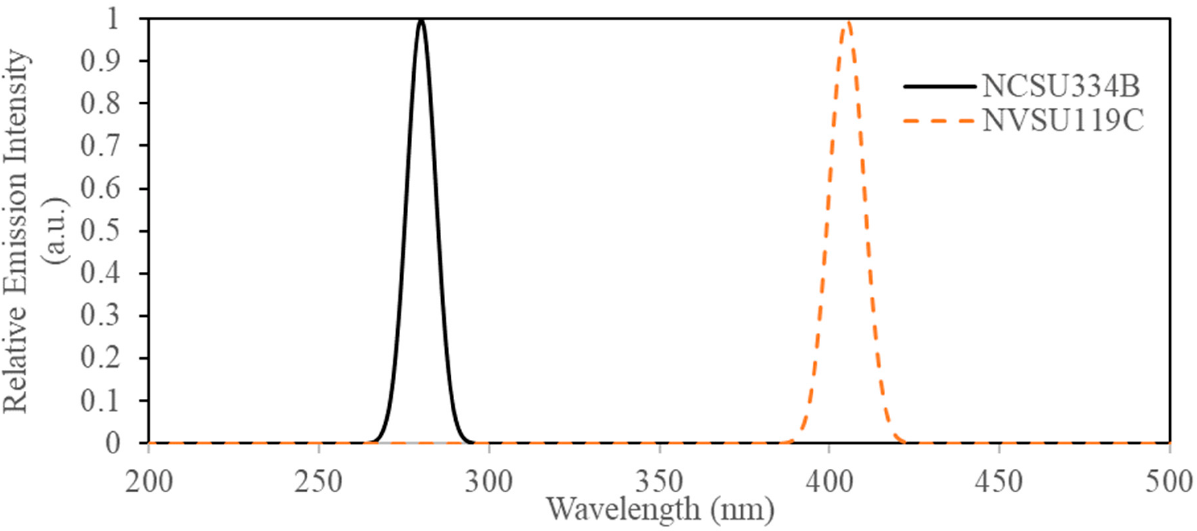
Figure 1. Relative emission intensity for NCSU334B and NVSU119C LEDs.